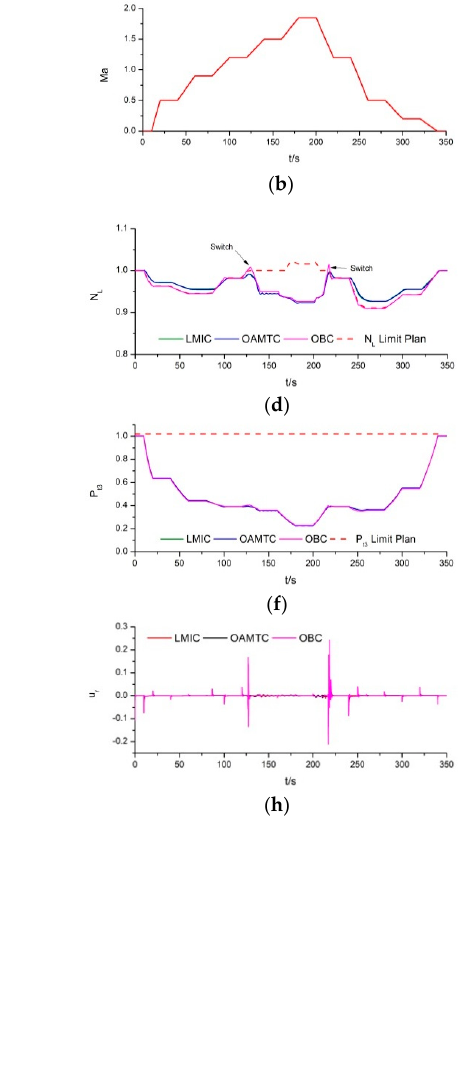
( f ) Figure 16. Simulation results of the acceleration limit management control under the ground condition: ( a ) PLA; ( b ) Corrected high-pressure rotor speed response; ( c ) Low-pressure rotor speed response; ( d ) High-pressure compressor outlet total pressure response; ( e ) Mixing chamber inlet total temperature response; ( f ) Controller index. In Figure 16b, it can be seen that the response speed of the OBC method is basically the same as that of the LMIC method, both of which have a faster response speed than that of the OAMTC method. From Figure 16b–e, it can be seen that all of the three limit management control methods (OAMTC, LMIC, and OBC) can realize the steady protection and transition limit protection of the engine, and there is no limit violation occurring. From Figure 16f, it can be seen that, for the LMIC and OAMTC methods based on the Min-Max scheme, the output limits are not exceeded before